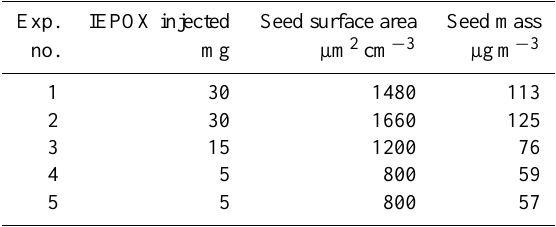
Table 1. Summary of conditions for each chamber SOA experiment.